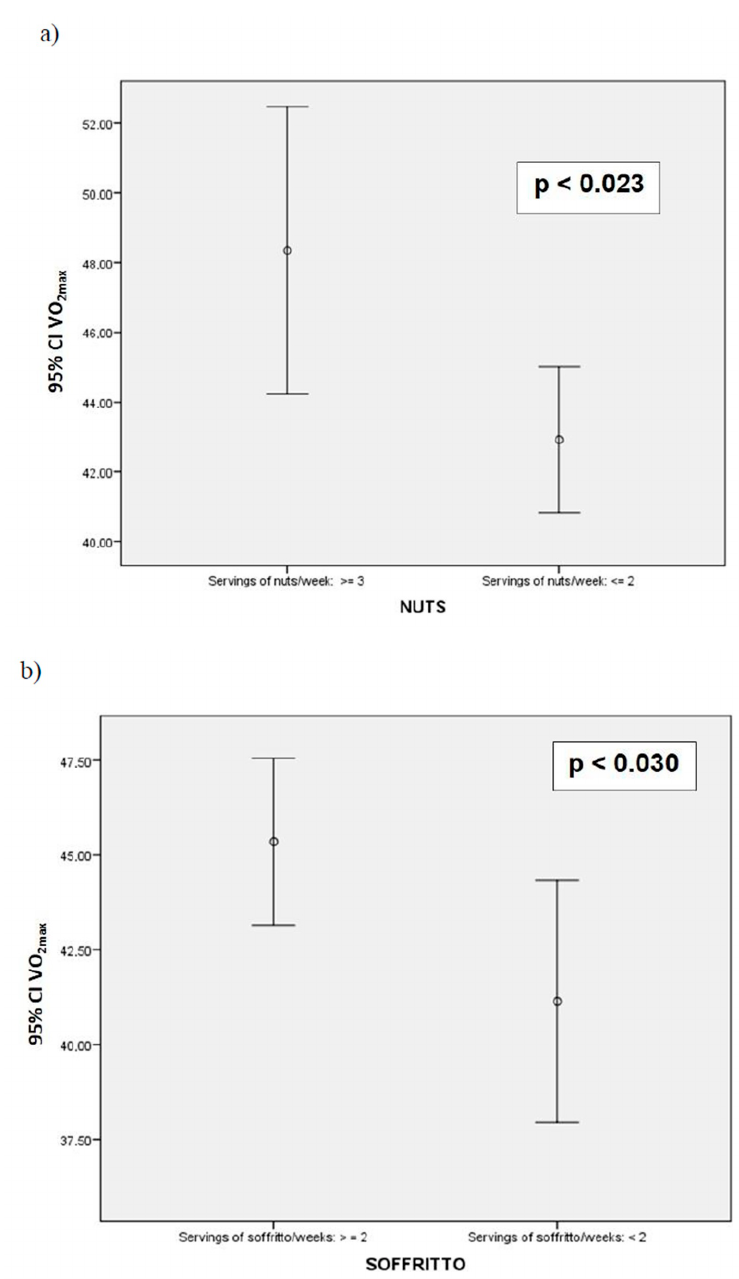
Figure 1. Cardiorespiratory fitness (VO 2max ) according to servings of nuts ( a ) and sauce with tomato and olive oil ( b ) consumption (Mediterranean Diet items: 12 and 14, respectively). Student’s t-test. Table 3. Characteristics of the participants according to VO 2max (low and high).